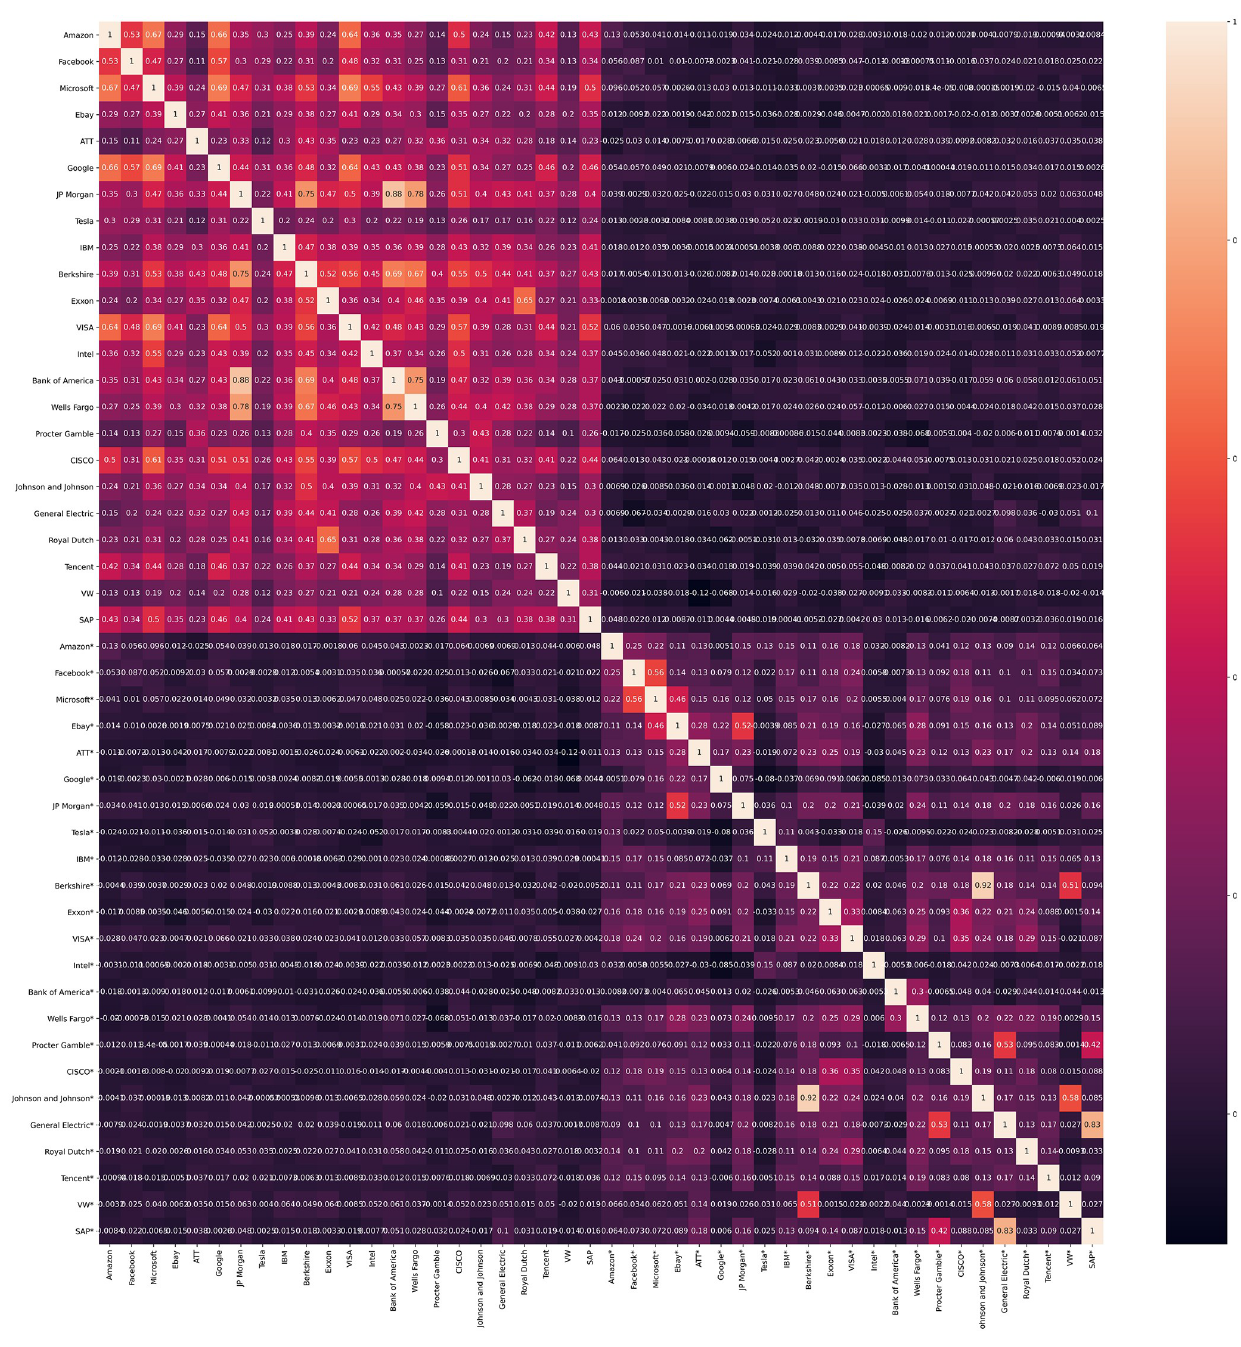
Fig 3. Correlation matrix of the companies and the Sentiment Indexes, it can be appreciated that the companies are considerably correlated and the same for the Sentiment Indexes, yet there is little to no correlation between stocks and Sentiment